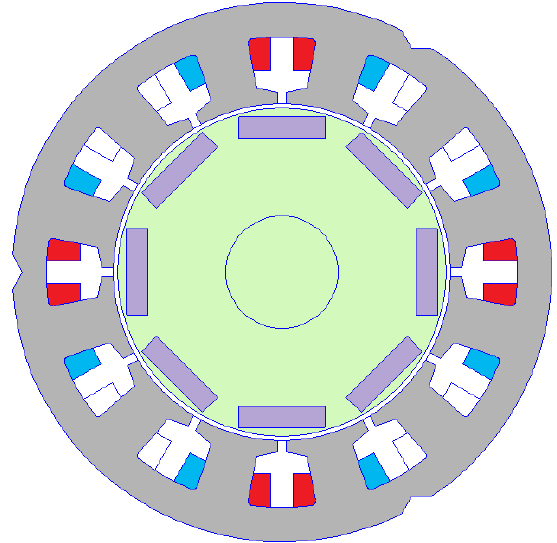
Figure 7. DCPM motor and stator segment with coils added. Table 4. List of ratios between useful torque and cogging torque in the DCPM motor being tested for full rotor revolution.